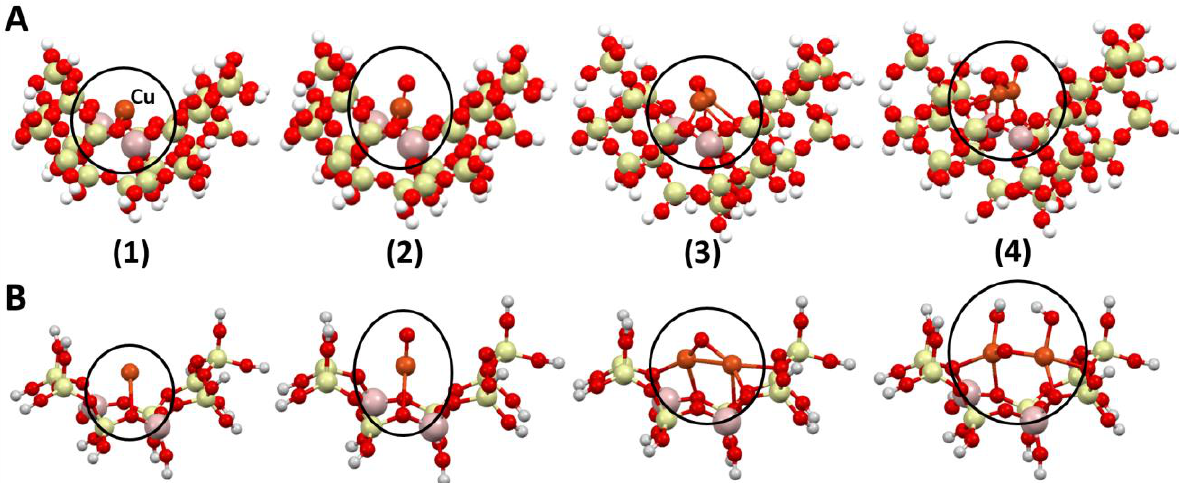
Figure 7. Copper models in ( A ) Y/USY and ( B ) ZSM-5. (1) Cu, (2) CuO monomer, (3) Cu 2 O dimer and (4) Cu 2 O(OH) 2 hydrated dimer; Cu — orange, Si — yellow, Al — pink, O — red, H — white.